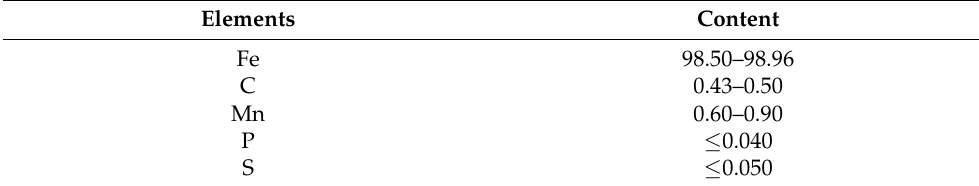
Table 2. The chemical composition of AISI 1045 steel.